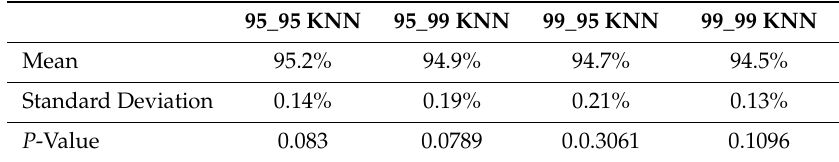
Table 13. Mean, standard deviation, and p -value for Anderson Darling test, for the RF models tested against cleaned sets.